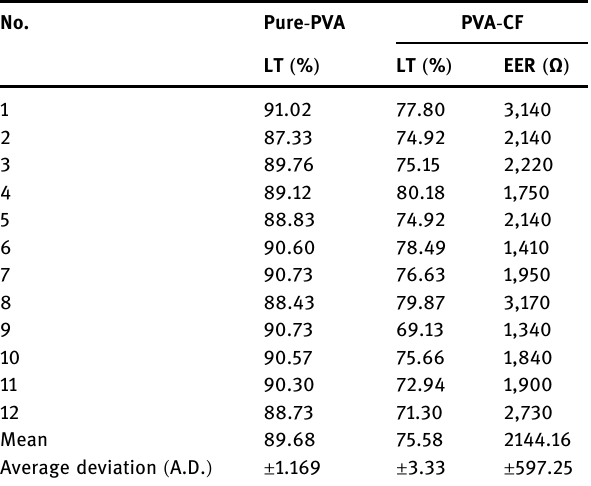
Table 3: Properties of fabricated pure - PVA with PVA - CF fi lm No. Pure - PVA PVA -